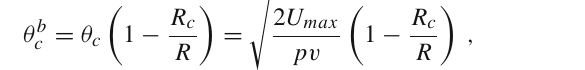
where U (cid:4) is the maximum gradient of interplanar elec- max ≈ tric potential. For the plane (110) in silicon crystal U (cid:4) max 6 GeV/cm, thus for 6.5 TeV/c positively charged particles R c ≈ 11 m. This implies an angular acceptance of the chan- ) neling process in bent crystals (θ b c